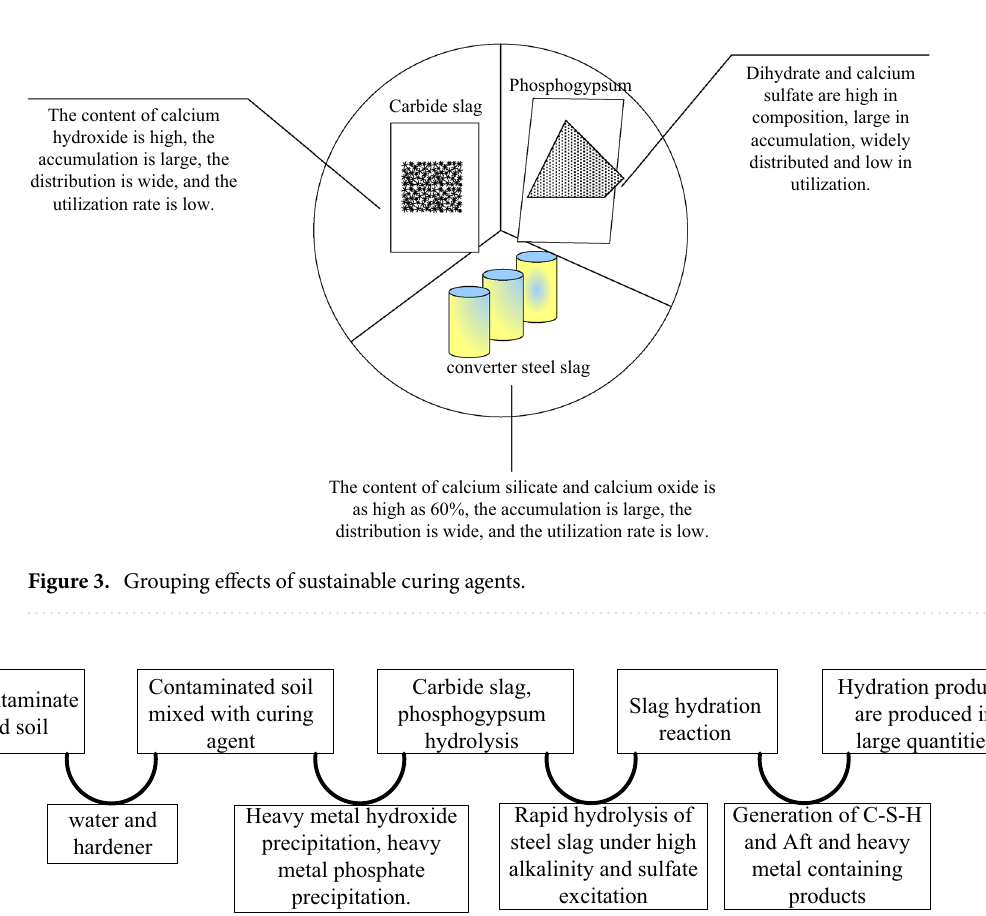
Figure 4. Reaction process of steel slag-based curing